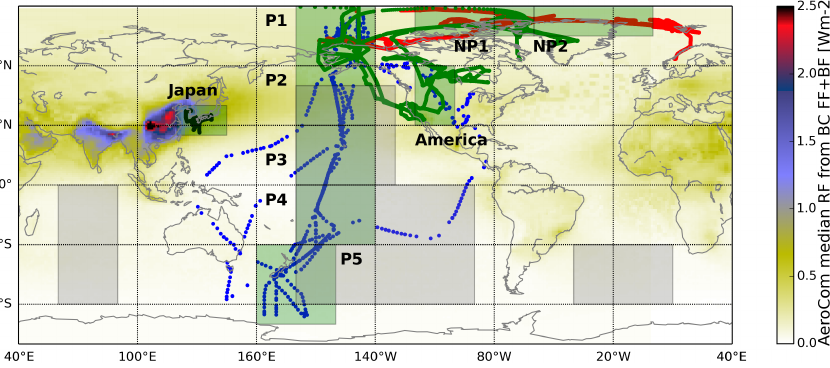
Figure 1. Flight tracks and regions selected for the analysis. Dots represent either single measurements (ARCTAS, A-FORCE, PAMAR- CMiP) or pre-averaged profiles (HIPPO) from the flight campaigns. Blue: HIPPO. Green: ARCTAS. Red: PAMARCMiP. Black: A-FORCE. Green boxes show the geographical regions where model data were averaged for comparison to the flight profiles. Grey boxes show the areas defined as “remote ocean”. The background map shows the median, annual mean RF due to fossil fuel and biofuel burning from the 13 models used in the present